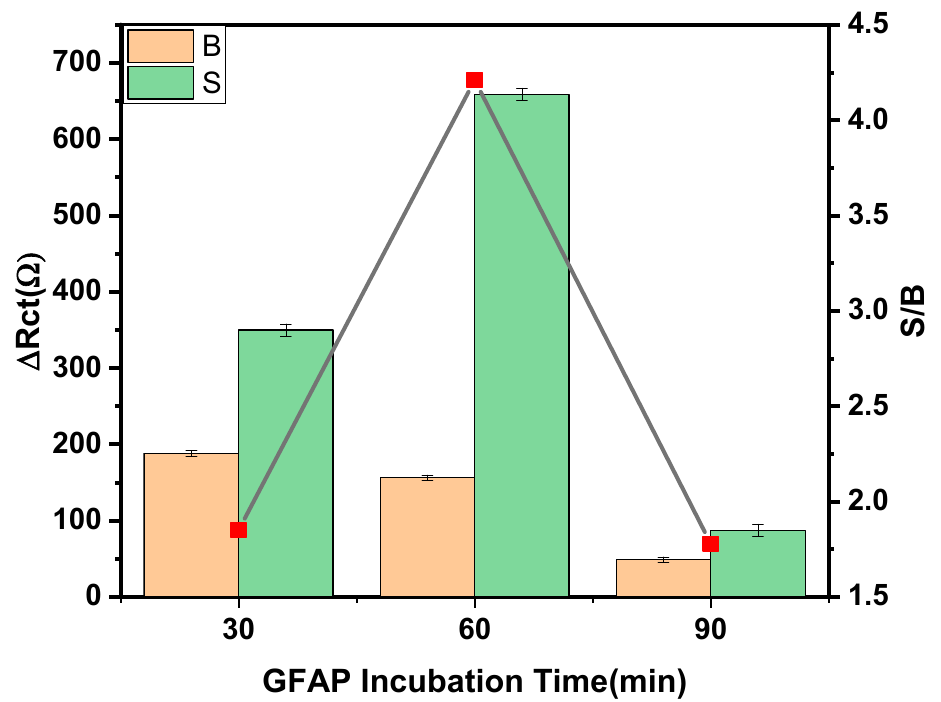
Figure 6. Optimization study of GFAP incubation time. Table 1. Experimental variables optimized in preparation for the Anti-GFAP/L-cys/AuNPs/SPCE immunosensor.